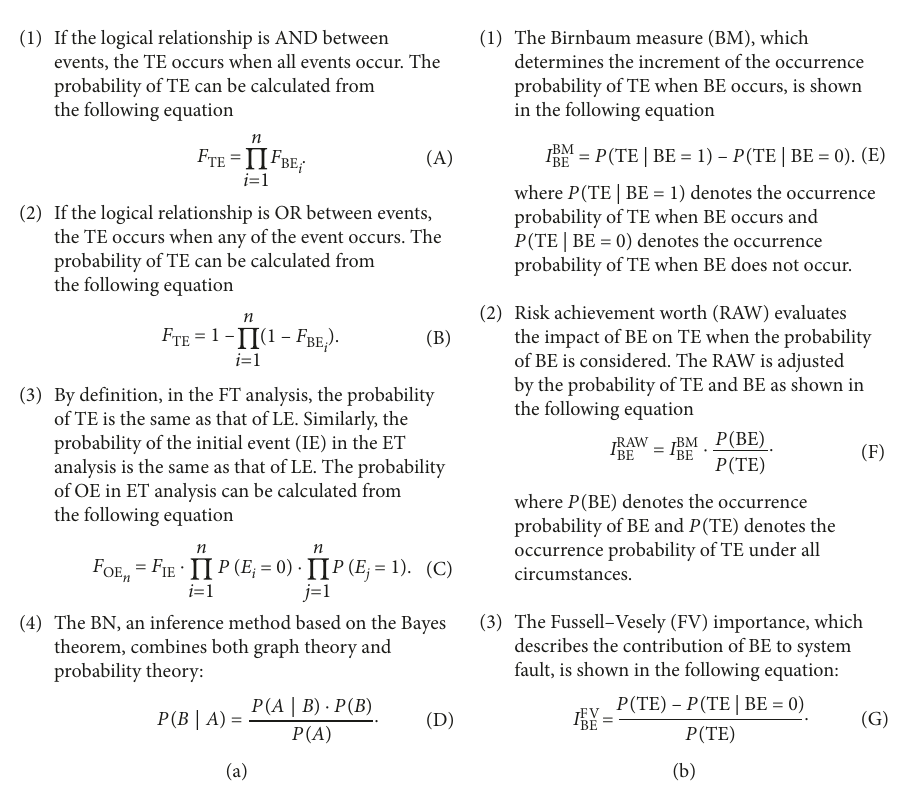
Figure 7: Bow-tie-Bayesian network analysis. Calculation of (a) event probability and (b) importance measures.